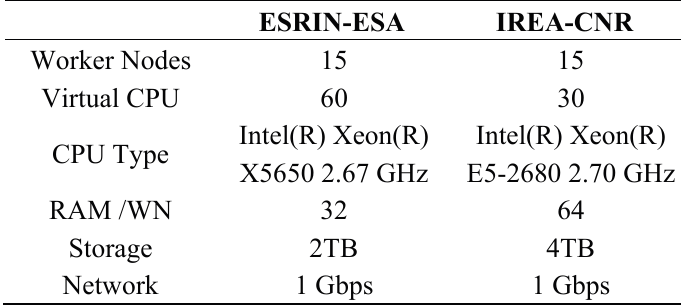
Table 1. G-POD resources dedicated to the P-SBAS web